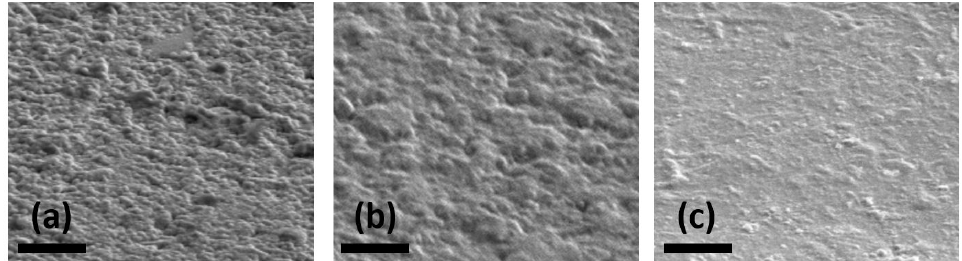
Figure 3. SEM images of the surfaces of ( a ) the Bisco Ortho Bracket Paste LC (Bisco), ( b ) Light-Cure Orthodontic Paste (Leone), and ( c ) Transbond XT TM Light Cure Adhesive (Trans) collected at a tilt angle of 52°. The scale bars indicate 10 μ m.